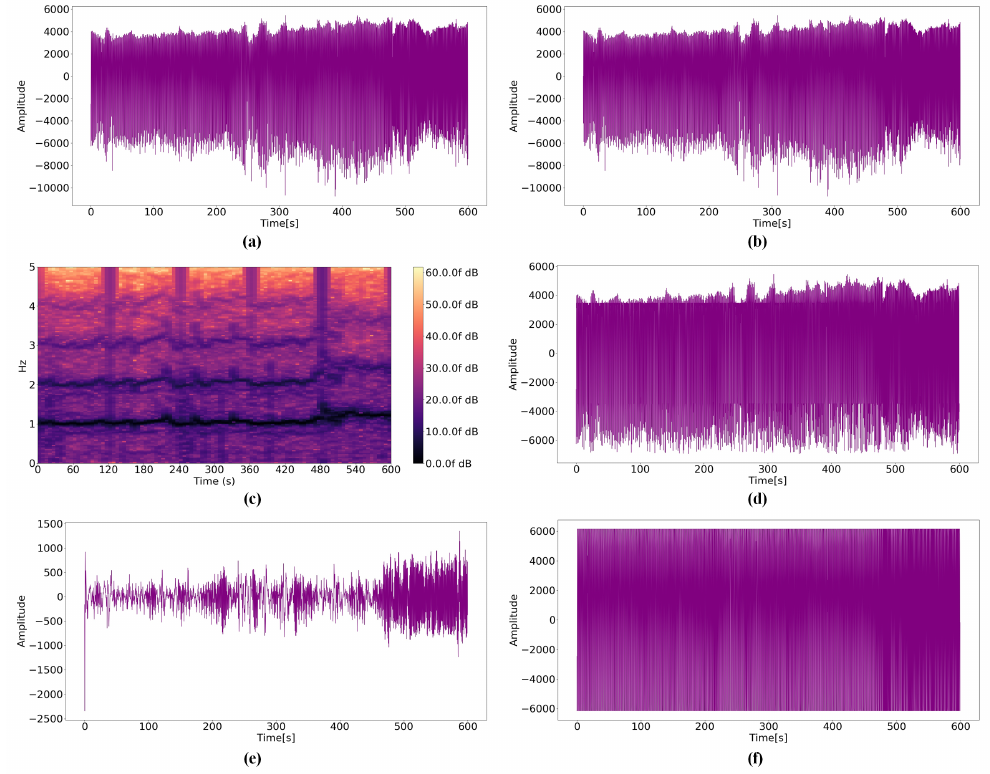
Figure 8. PPG signals for a distance 0 mm: ( a ) Raw data; ( b ) Kalman filter; ( c ) STFT; ( d ) Modified average filter; ( e ) BPS+SMA filter; ( f ) WA